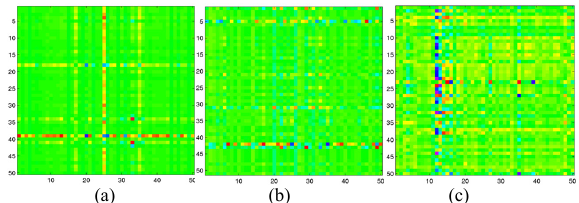
Fig. 3. Example results of the learned weight parameters over the Pavia University data set: (a) is the learned weight parameters of the second layer of original DBN, (b) and (c) are the weights diversified by D-DBN-P and D- DBN-PF respectively.